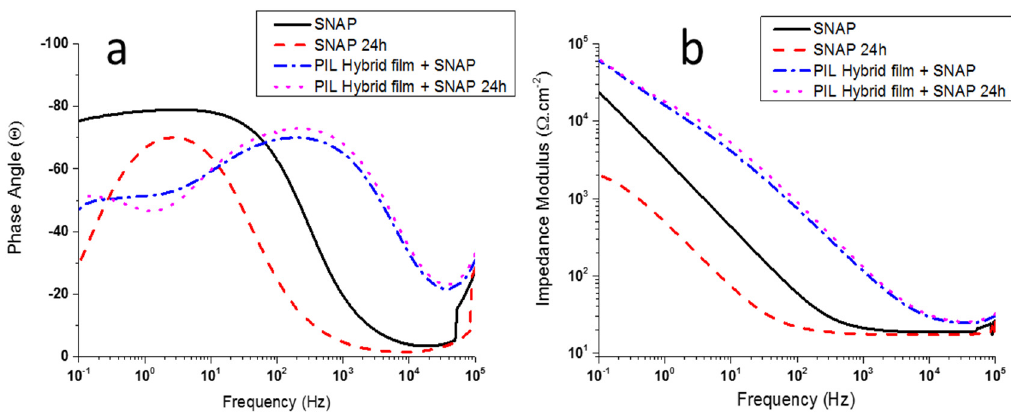
Figure 8. ( a ) Phase angle; ( b ) Impedance modulus of the SNAP ‐ coated samples with and without the PIL interfacial PIL interfacial layer.